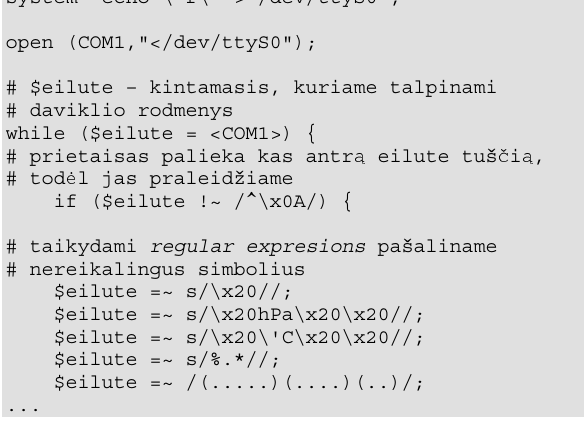
Fig 2 . Fragment of Perl script for treatment and transfer of the meteorologic